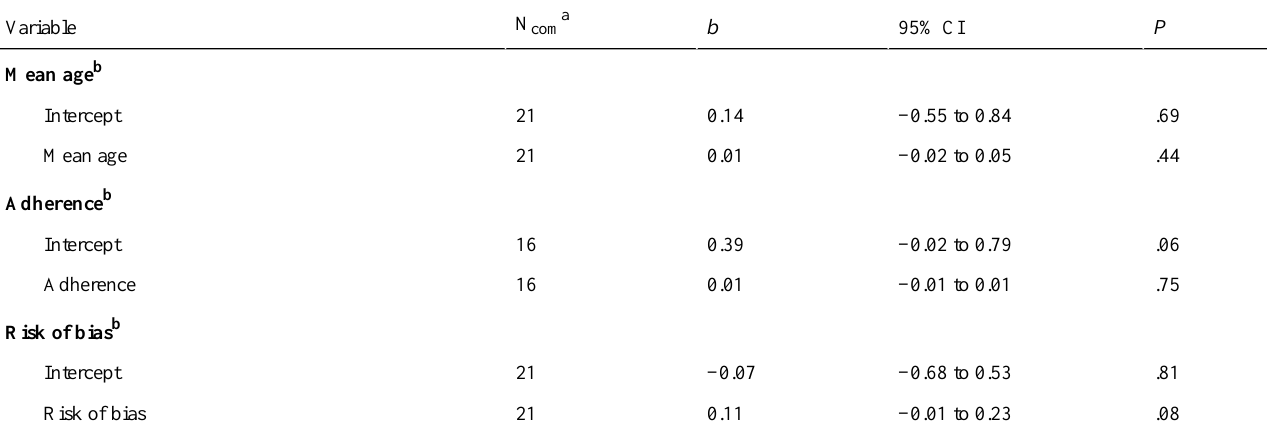
Table 3. Bivariate meta-regression analyses regarding depressive symptoms in studies comparing computerized cognitive behavior therapy in adolescents and young adults with active treatment and passive controls at